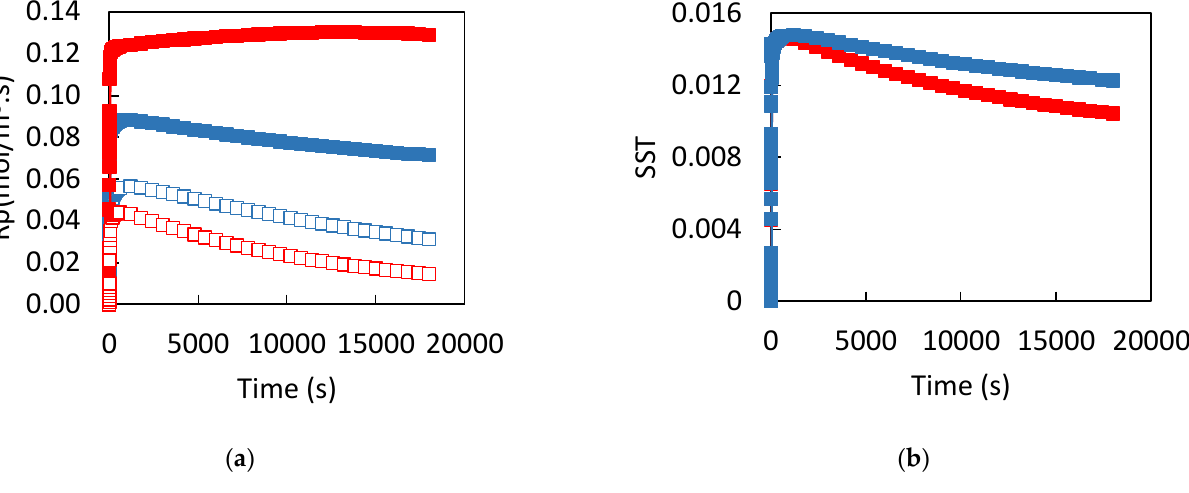
Figure 12. Evolution of ( a ) Rp and SST( b ) as a function of time (s) for ( □) 𝐿0 𝑎𝑛𝑑 ( ) S with (blue) the fixed porosity case and (red) the variable porosity case